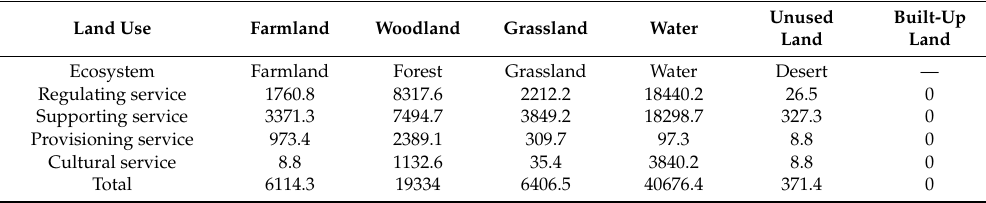
Table 1. Ecosystem services value per unit area of di ff erent terrestrial ecosystems in China [22] (yuan / ha / yr).